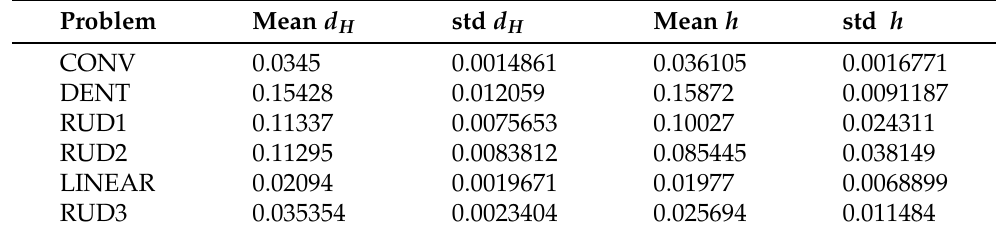
Table A1. Hausdorff distances d H and approximations h computed by ArchiveUpdateHD for the six bi-objective problems.